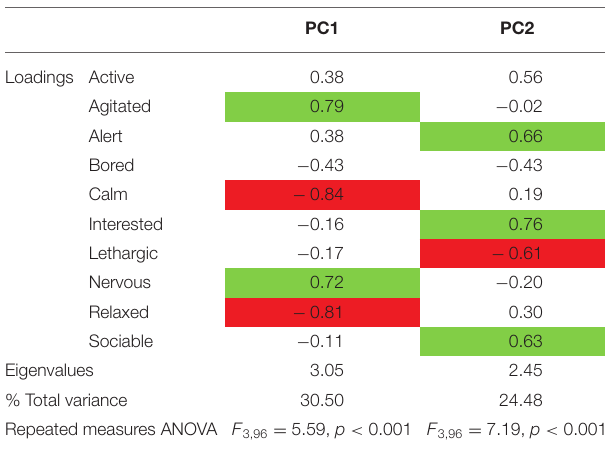
TABLE 2 | Loadings, eigenvalues, total variance, and repeated measures ANOVA of PCA.